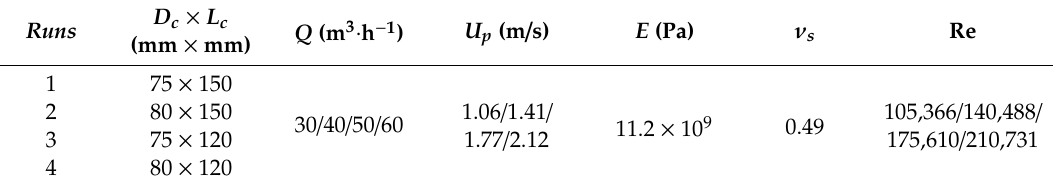
Table 1. The summary of experimental parameters.